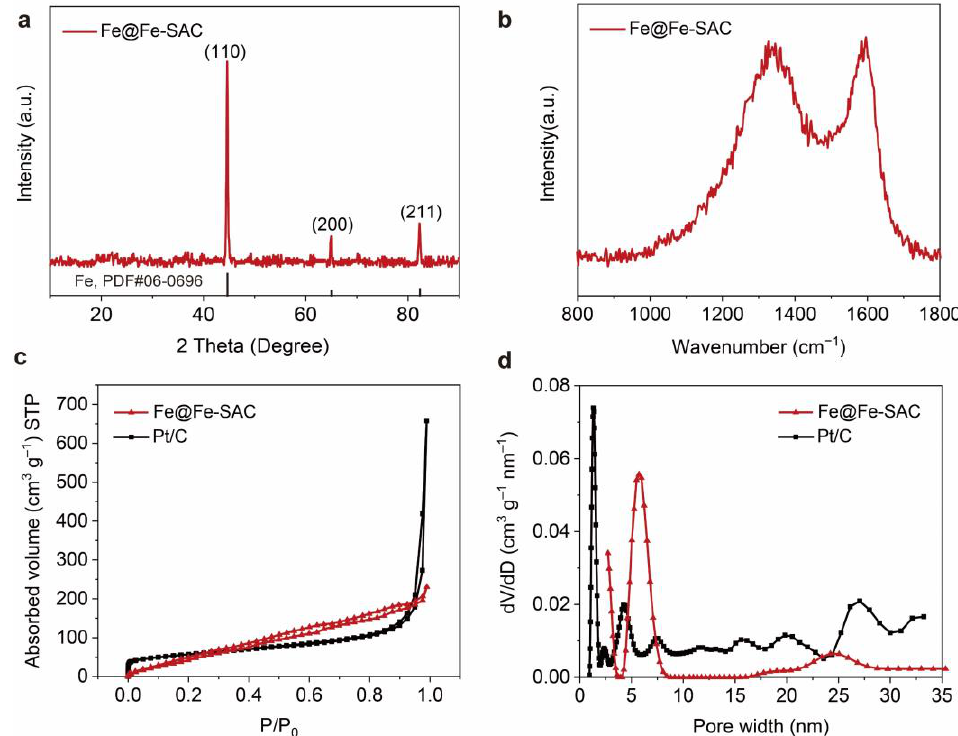
Figure 1. ( a ) X-ray diffraction pattern, ( b ) Raman spectra, ( c ) Nitrogen adsorption–desorption isotherm, and ( d ) pore size distribution of Fe@Fe-SAC.